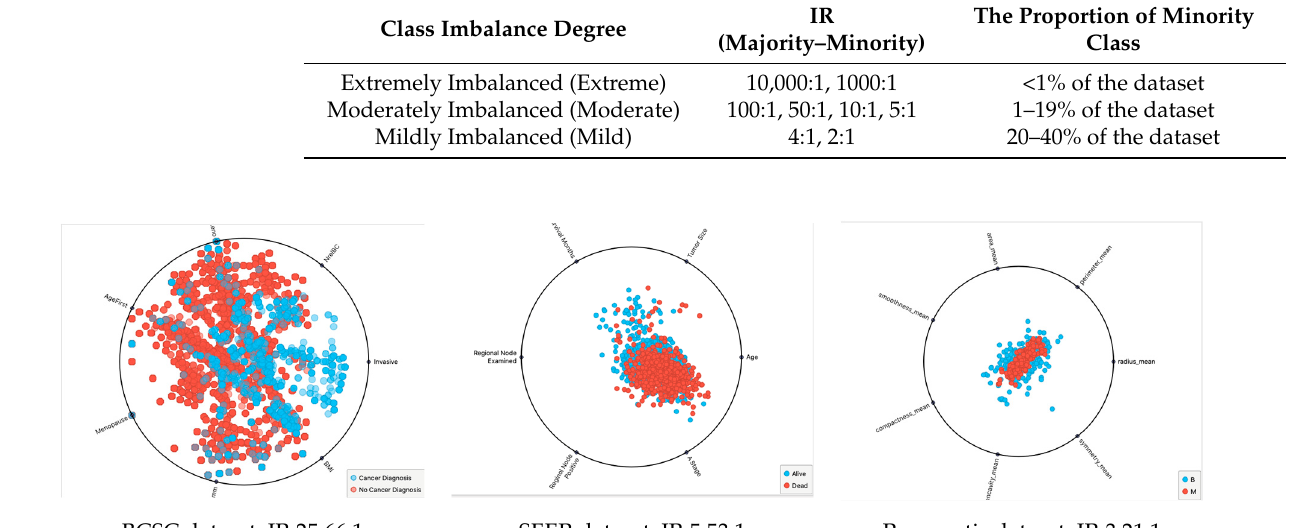
Table 1. Benchmark of the degree of imbalance in data.